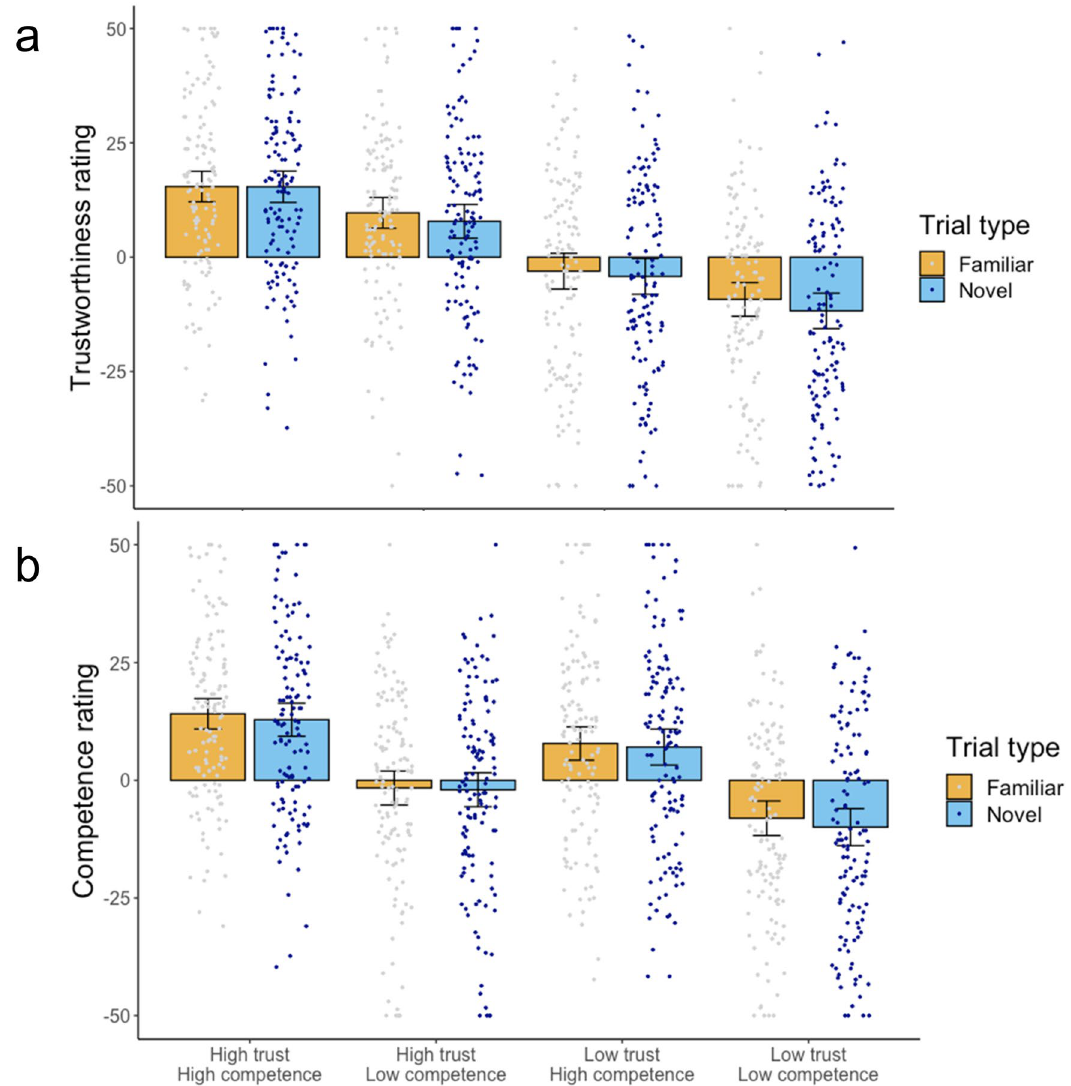
Figure 6. ( a ) Results from Experiment 5, judgements of trustworthiness. ( b ) Results from Experiment 5, judgements of competence. Error bars represent 95% confidence intervals around the